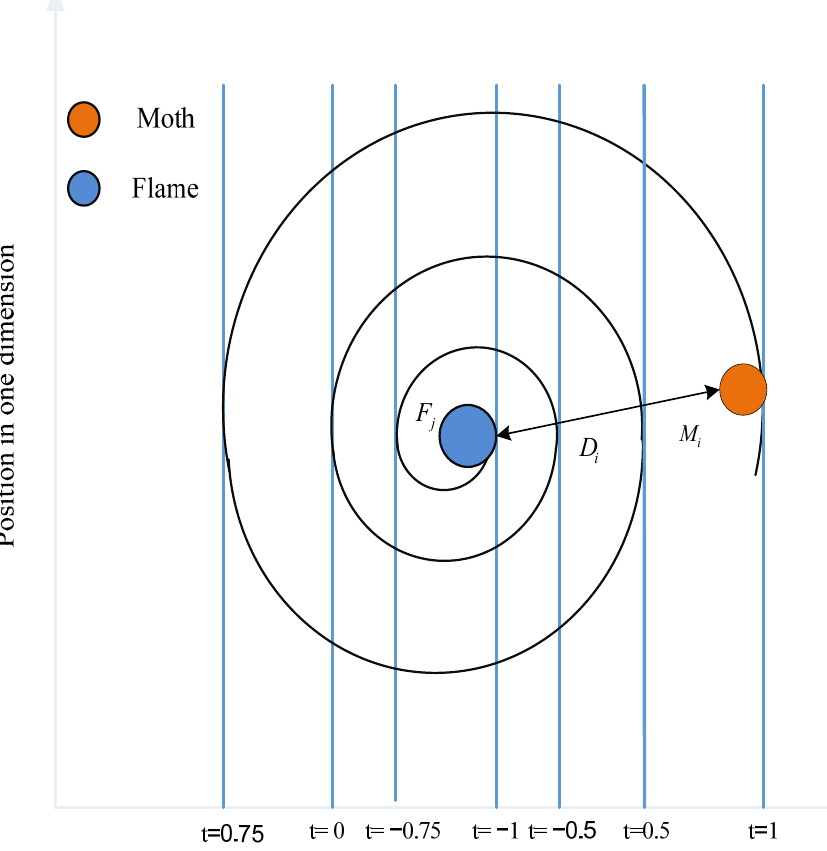
Figure 12. Space surrounding a flame, a logarithmic spiral, and the position in relation to t. While it simply requires the moths to move in the direction of the flame, the position update in Equation (67) results in the MFO algorithm becoming rapidly stuck in the local optima. To avoid this situation, each moth is required to update its location by utilising just one of the flames in Equation (67). The flames are sorted according to their fitness levels after the list of flames is updated after each iteration. In relation to their associated flames, the moths then update their positions. The first moth always adjusts its position in relation to the best flame in the list, whereas the last moth does so in relation to the poorest flame. Another issue with this approach is that the exploitation process can suffer